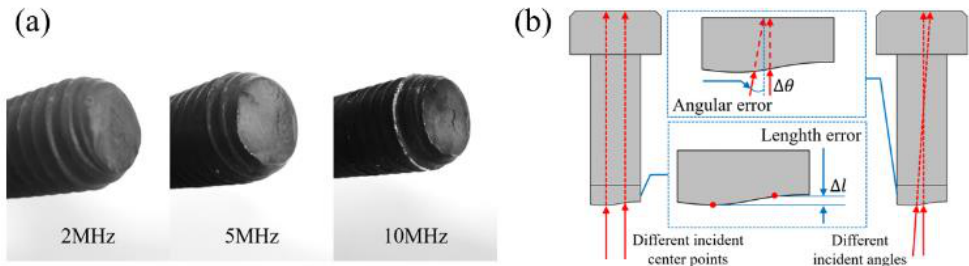
Figure 11. ( a ) Photograph of the bottom − end faces of three intelligent bolts; ( b ) errors caused by incident center and incident angle offset.